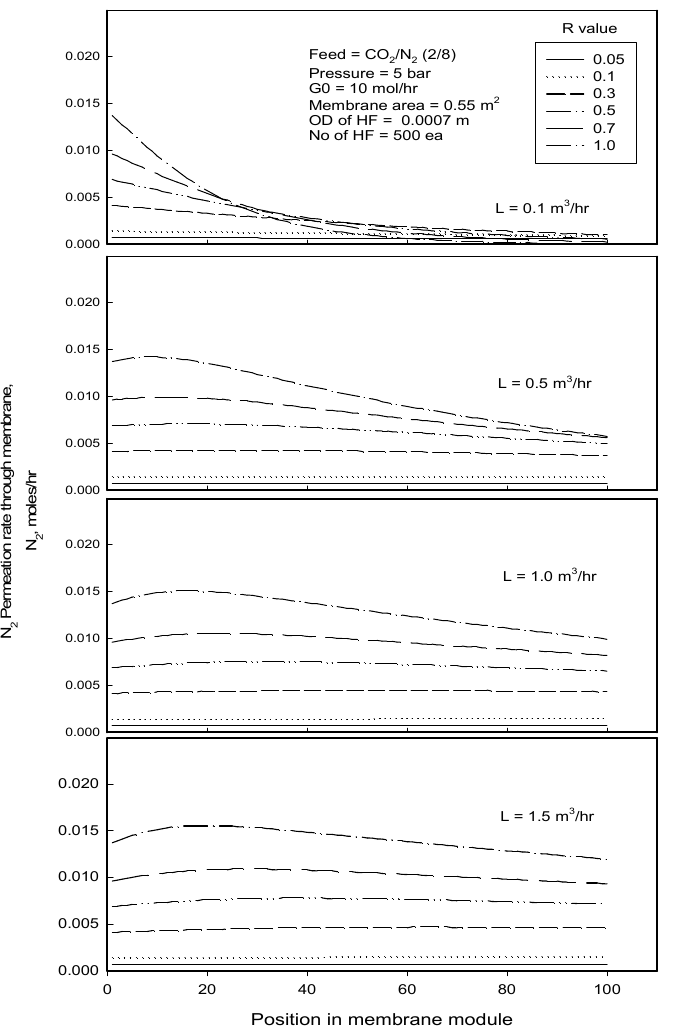
Figure 9. N 2 permeation rate simulated with the position of membrane module in gassing process for the separation of CO 2 /N 2 mixture at different liquid flow rates and R-values.